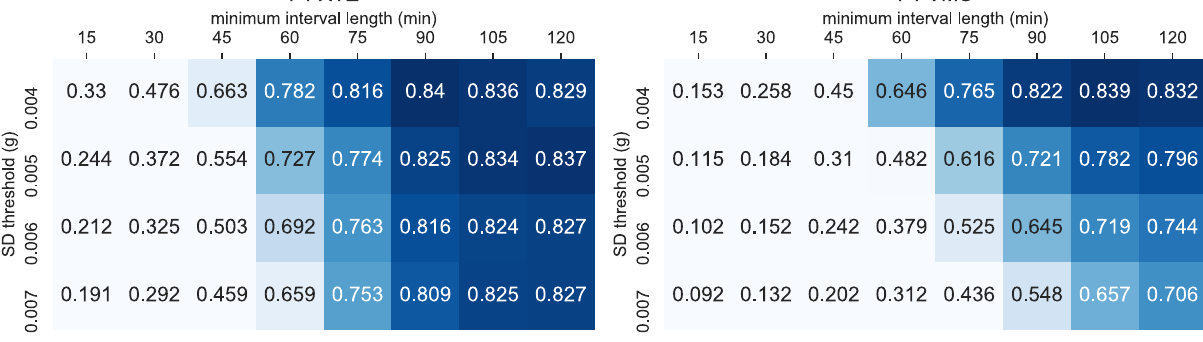
Figure 4. The F1 classification performance of the XYZ baseline algorithm (left), and the VMU baseline algorithm (right). Note that a SD threshold of 0.003 g performed poorly as it is below the accelerometer noise level and is therefore not shown. See Supplementary Figs. S4 and S5 for accuracy, precision, and recall scores.